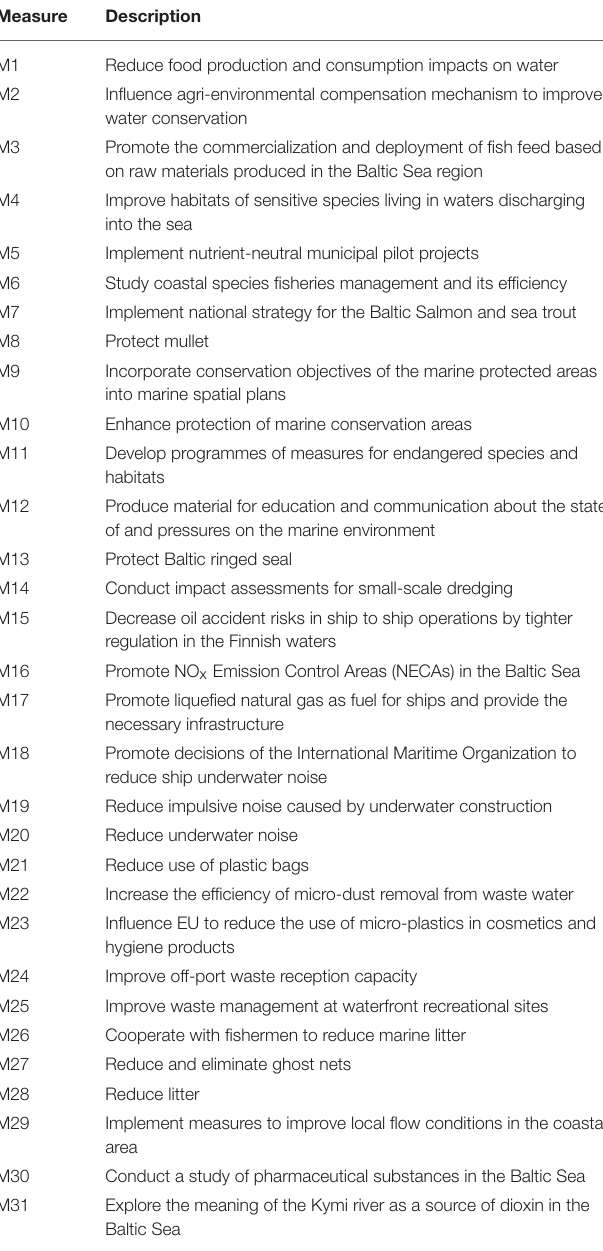
TABLE 3 | New measures in the Finnish PoMs (source: Oinonen et al.,